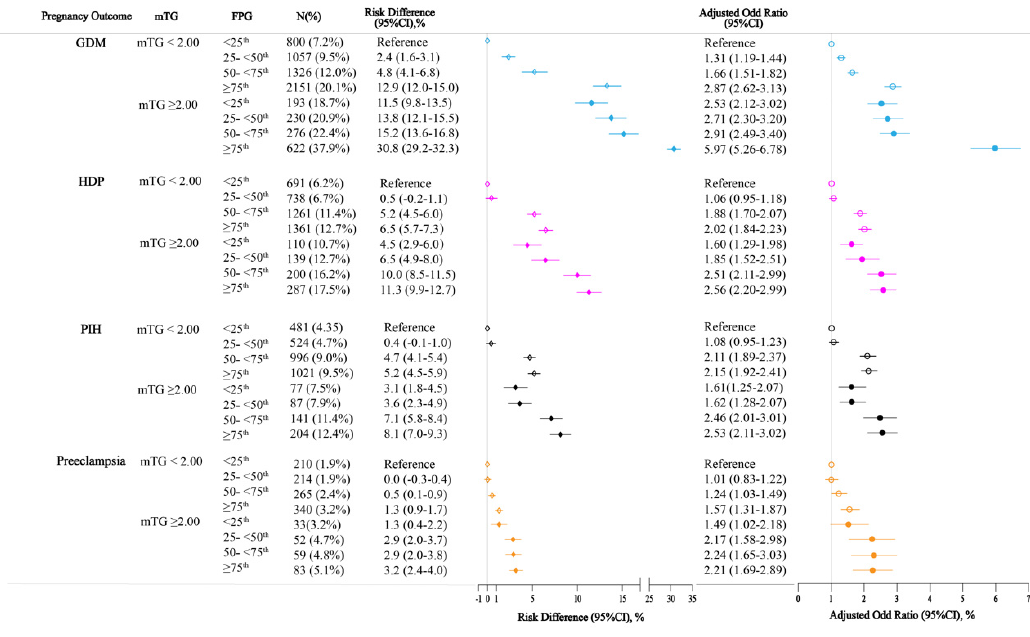
Figure 2. Combined effects of early-pregnancy FPG and mTG on pregnancy